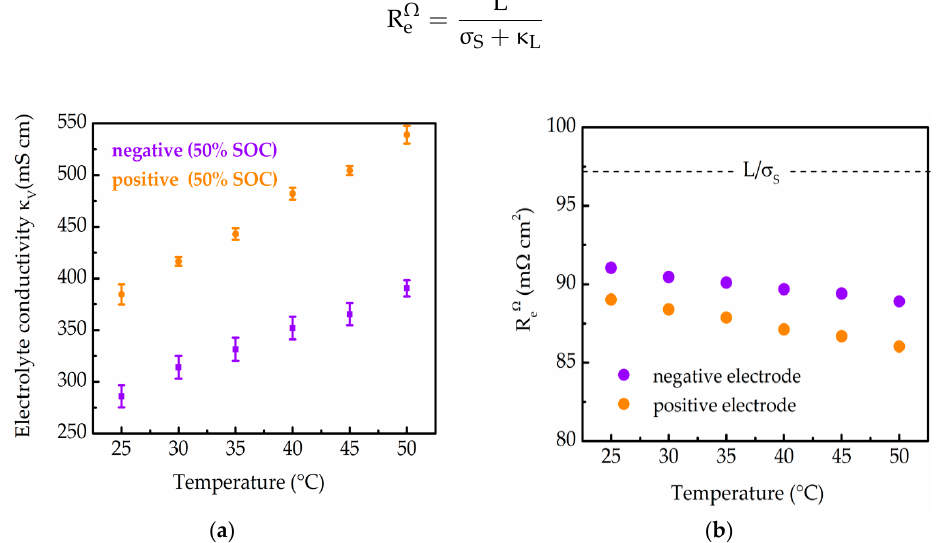
Figure 2. ( a ) Measured electrolyte conductivities ( κ V ) and ( b ) calculated total Ohmic electrode resistances (R eΩ ) for negative and positive electrolytes/electrodes at temperatures from 25 to 50 °C. As expected, the conductivities of both half-cell electrolytes increase with temperature as shown in previous studies [37].